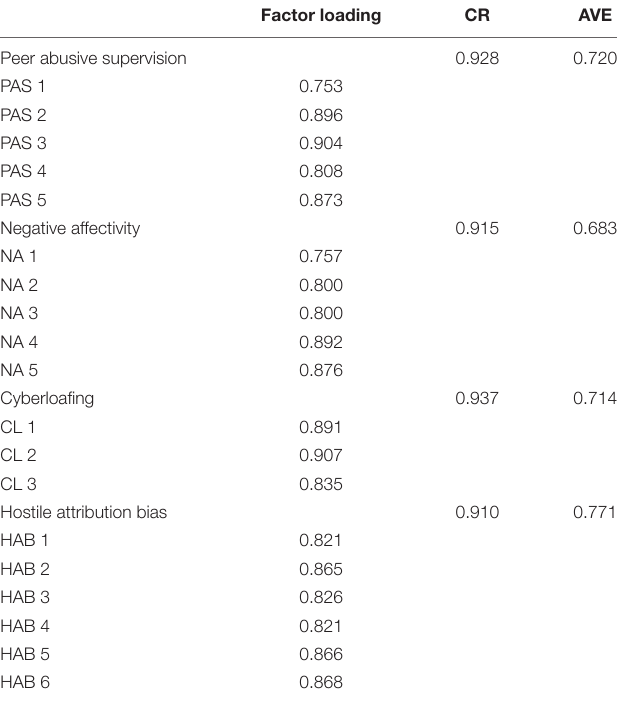
TABLE 2 | Reliability and validity ( n =